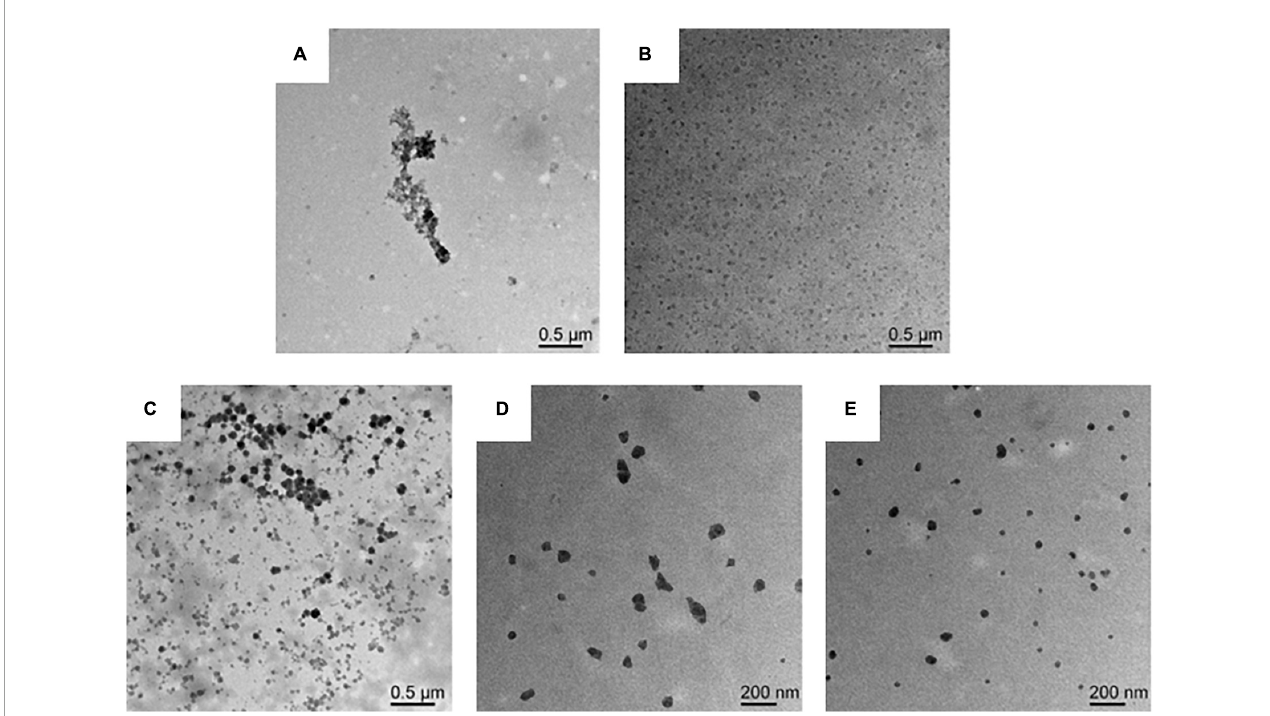
FIGURE3 (A) Transmission electron microscopy (TEM) image of WPI solution. (B) TEM image of SPI solution. (C) TEM image of composite nanoparticles prepared by WPI: SPI (w/w) mass ratio of 1: 0.1. (D) TEM image of composite nanoparticles prepared by WPI: SPI (w/w) mass ratio of 1: 0.5. (E) TEM image